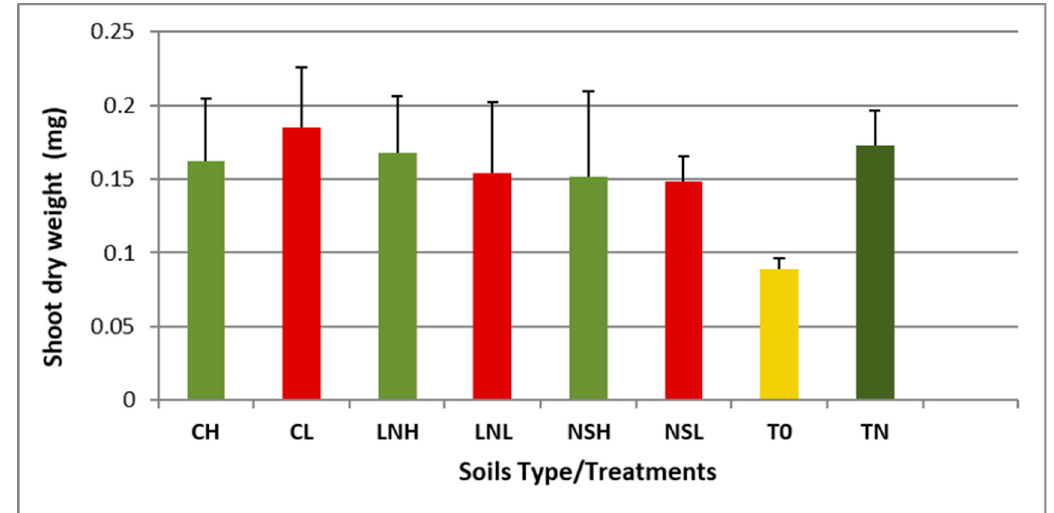
Figure 4. Dry weight of Vigna unguiculata plants inoculated with different soil samples. Population